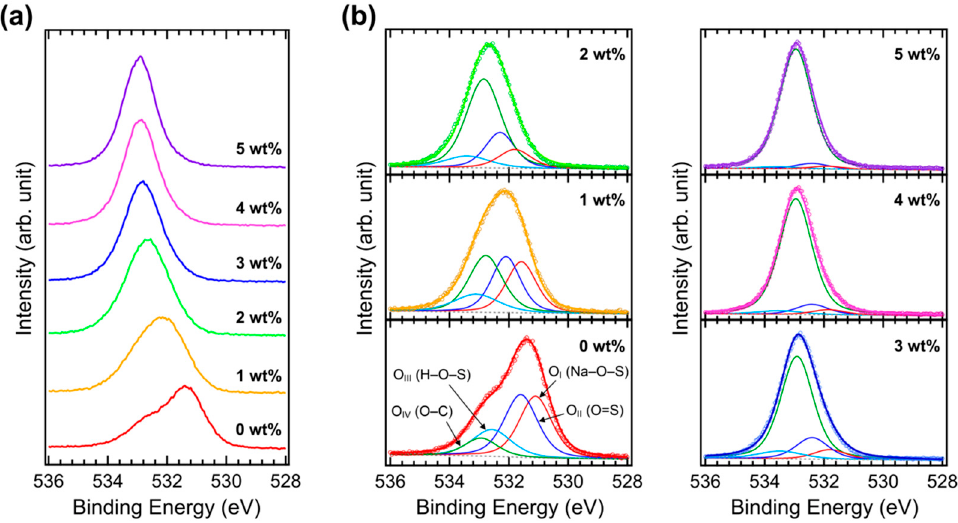
7 of 13 Figure 3. ( a ) XPS S 2p spectra of PEDOT:PSS films on ITO with various concentrations of Brij C10 additive (0, 1, 2, 3, 4, and 5 wt%) and ( b ) their fittings. Figure 4a shows the O 1s XPS spectra of the Brij C10-mixed PEDOT:PSS films on ITO. In the pristine PEDOT:PSS, several oxygen peaks are convoluted. However, only one peak at high binding energies becomes dominant as Brij C10 is added. Figure 4b shows the fittings of the measured O 1s XPS spectra. Four components are assigned to the pristine PEDOT:PSS; that is, the O I peak at 531.1 eV from the Na–O–S bond in PSS, the O II peak at 531.6 eV from the O=S bond in PSS, the O III peak at 532.6 eV from the H–O–S bond in PSS, and the O IV peak at 532.9 eV from the O–C bond in PEDOT and PSS. The O III peak is known